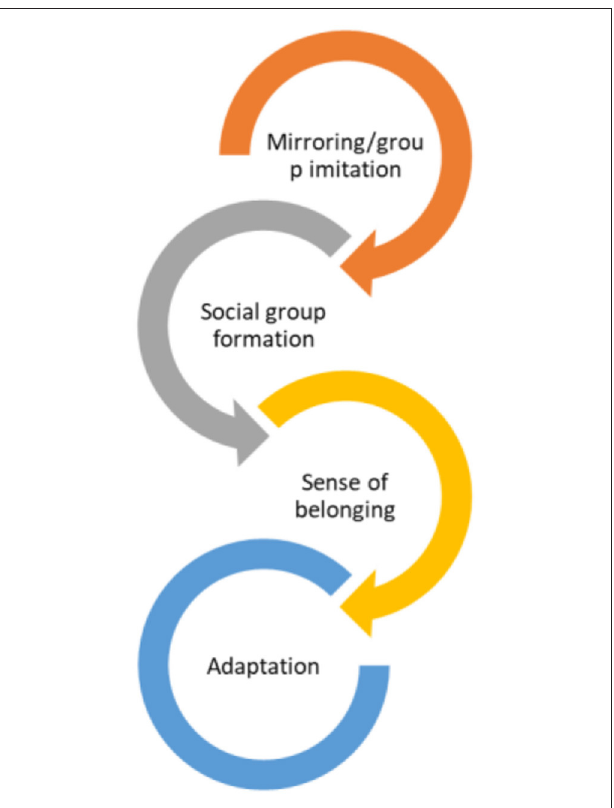
FIGURE 4 | Dynamics between elements −